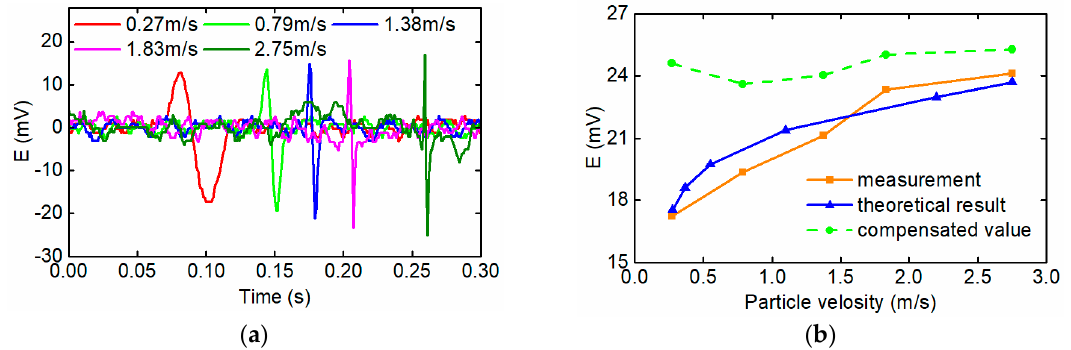
Figure 14. ( a ) Induced electromotive force caused by a wear particle with different speeds; ( b ) Comparison analysis between measurement and theoretical